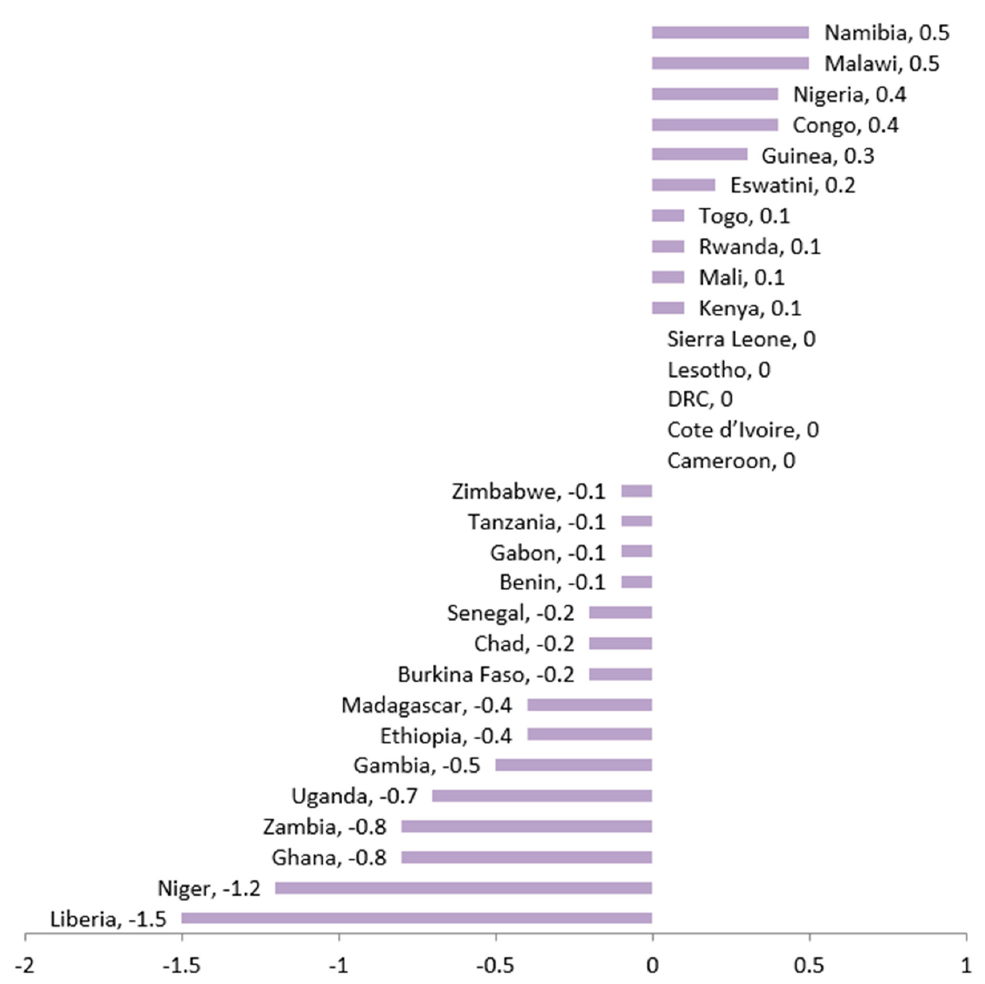
Figure 2. Change of stunting prevalence in rural relative to urban residence (rural-urban) over 1998–2008 to 2009–2018 periods. The graph presents excess changes relative to urban residence; negative values are desirable outcomes as it means faster changes in stunting are happening in the most disadvantaged group.